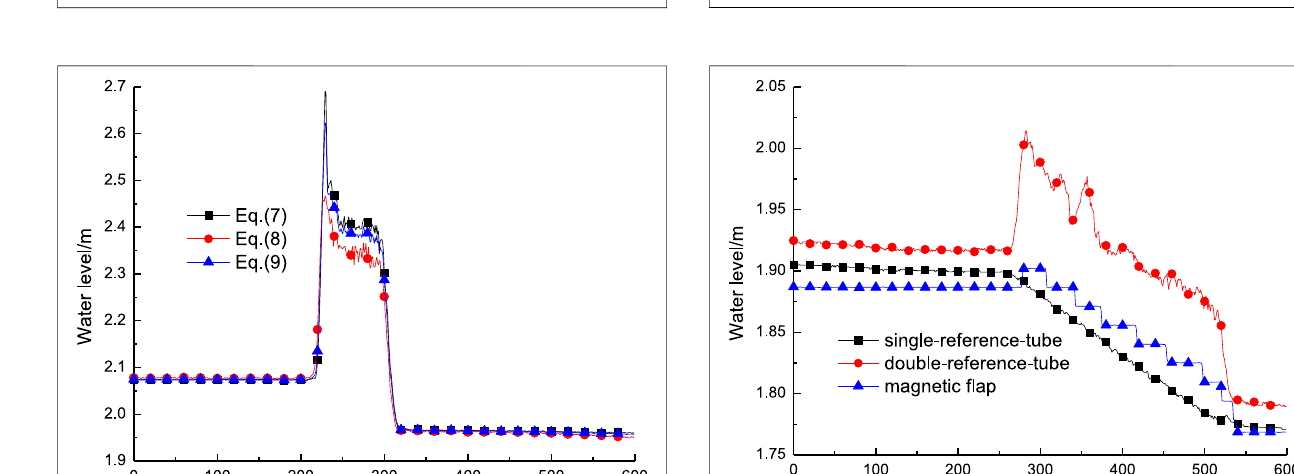
FIGURE 7 | Water levels of fast depressurization.